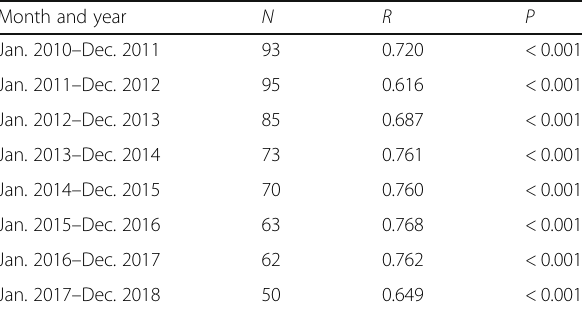
N number of hospitals, R correlation coefficient (Spearman ’ s non-parametric correlation), P two-tailed significance Positive correlation coefficient means that hospitals with lower/higher HSMRs are likely to get same results in the following